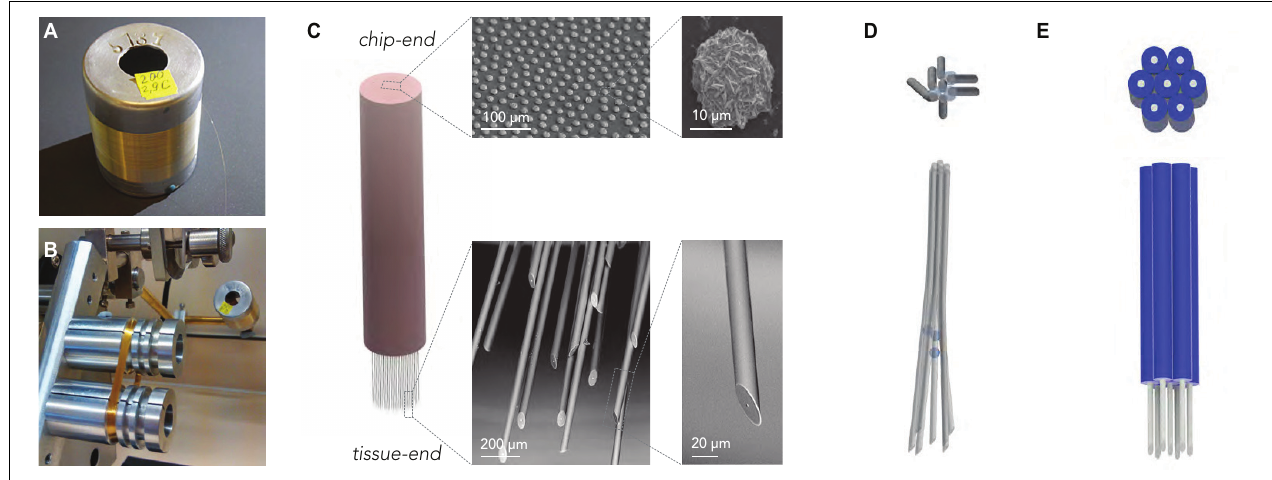
FIGURE 2 | Scalable fabrication of CHIME electrode bundles. (A) Cast glass-insulated metal microwires are produced in several-km-long, continuously conductive stretches. (B) The flexibility and robustness of the composite wires allow the preparation of large wire-count bundles by spooling. The image shows a 1000-wire bundle prepared on a fiber winding machine. (C) The bundle is embedded into polymer, and both ends of the fiber bundle are altered with scalable procedures. For optimal contact with the electronics, the chip-end of the embedded bundle is polished flat, and the exposed metal conductor cores at the chip-end of the wires are increased by electrochemical gold deposition (SEM images top row). The tissue-end of the wires is sharpened to limit tissue damage (SEM images bottom row) and electrochemically modified to optimize recording capabilities in the extracellular electrolyte (not shown, see Racz et al., 2019). (D) Regular electrode spacing achieved by a sacrificial layer deposited onto the microwires before